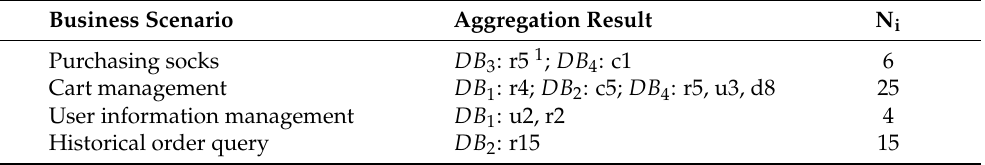
Table 9. The aggregation results of business scenarios in Sock-Shop.